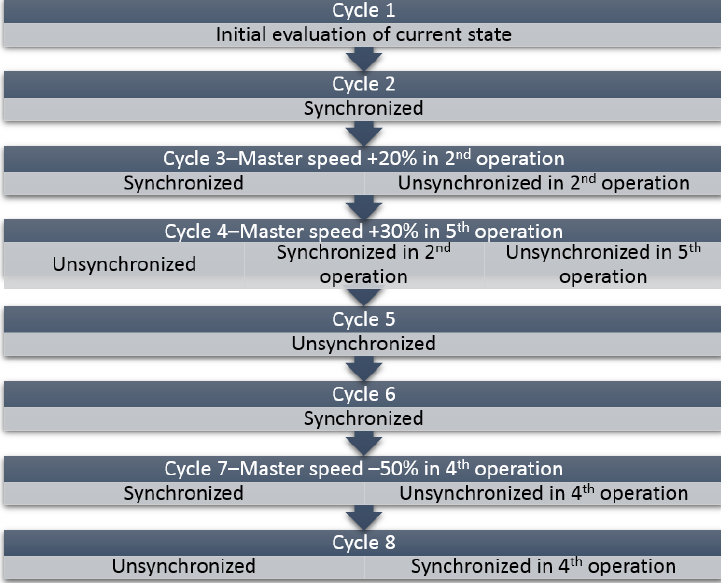
Figure 6. Brief summary of Experiment 1a results.